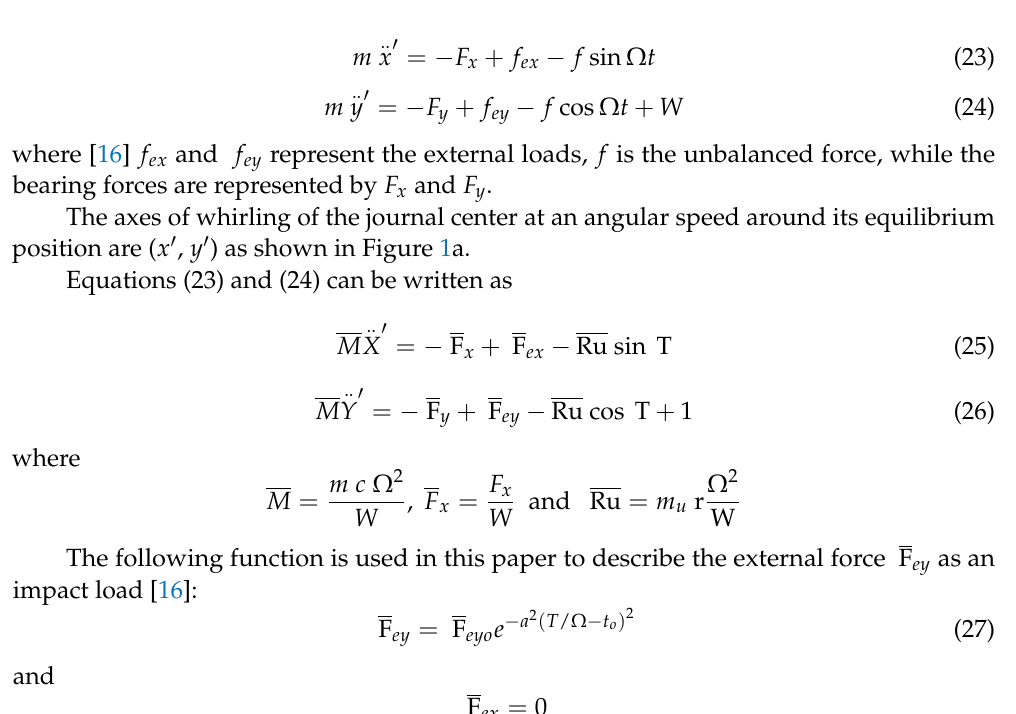
Figure 1. Bearing system: ( a ) side view of the journal bearing; ( b ) supported rotor [36]